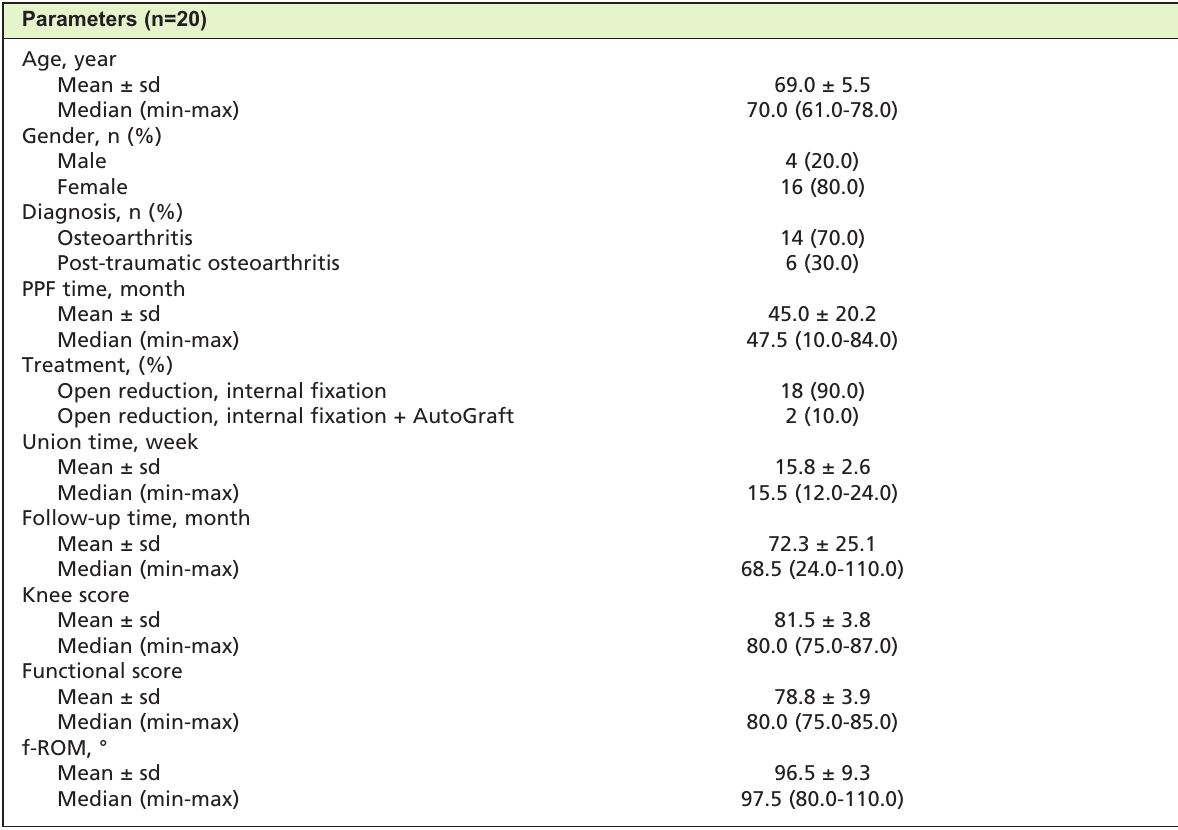
Baseline characteristics Table I: